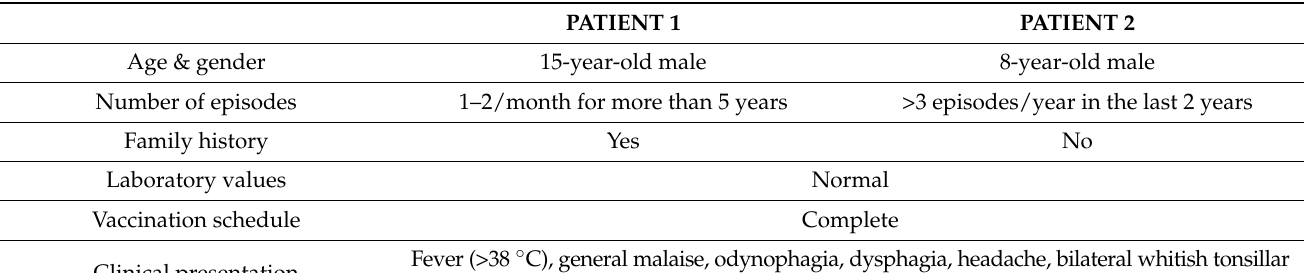
Table 1. Main characteristics of the two patients